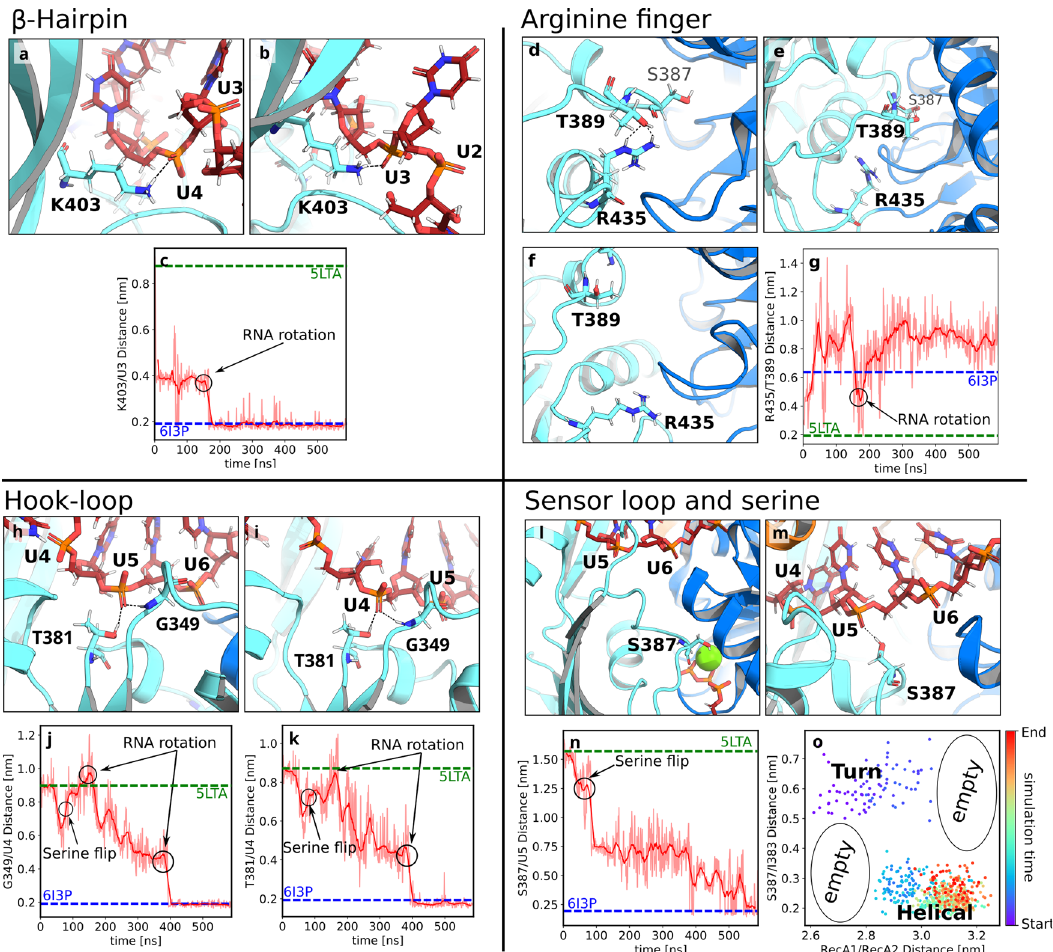
Fig. 3 Molecular switches of the opening process. Conformational transitions of ( a – c ) the β -hairpin, ( d – g ) the arginine fi nger, ( h – k ) the hook-loop, and ( l – o ) the sensor loop during Prp43 opening. ( a , d , h , l ) Molecular switches in the initial and (b/f/i/m) fi nal frames of adaptive sampling of the open process. ( c , g , j , k , n ) In the distance plots, the time averages are drawn as dark red lines while the underlying data is drawn in pale red. Critical atomic distances that quantify the progression of the opening transition, where dashed lines indicate the distances in the 5LTA and 6I3P crystal structures. a View from the backside of Prp43: K403 of the β -hairpin hydrogen bound to U4 in closed conformation and ( b ) shifted from U4 to U3 in open conformation. c K403 – U3 distance versus cumulative simulation time. d Closed RecA1 – RecA2 interface with the Arginine fi nger R435 hydrogen bound to T389 and located on top of the P-loop. e Broken R435 – T389 hydrogen bond after 5 ns. f Final conformation with distant R435 and T389 residues and with the arginine fi nger located underneath the P-loop. g R435 – T389 distance versus cumulative simulation time. h Closed conformation, hook-loop bound to U5 via G349 and T381. i Open conformation, G349 and T381 shifted from U5 to U4. S387 formed an H-bond to U5 similar to the conformation in panel M. j G349 – U4 distance and ( k ) T381 – U4 versus cumulative simulation time. l Serine fi nger S387 bent towards the ATP in closed conformation and ( m ) pointing towards the RNA forming an H-bond with U5. n S387 – U5 distance versus cumulative simulation time. o S387 – I383 distance vs. RecA1 – RecA2 distance, revealing a marked correlation between the sensor serine conformation (helical or turn) and Prp43 opening. Supplementary Fig. S12 shows the relative position of the zoom-in features to the overall